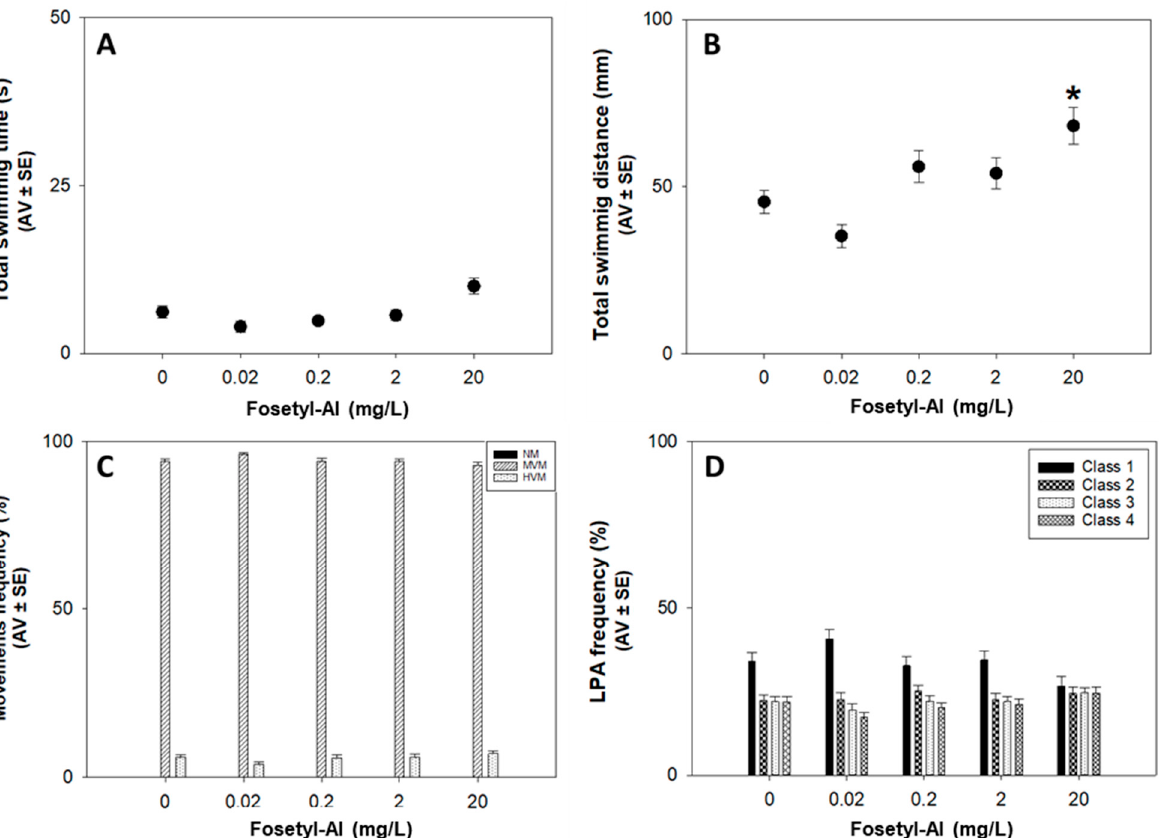
Figure 2. Effects of 120 h of exposure to fosetyl-Al on zebrafish larvae for total swimming time ( A ) and distance ( B ); types of movements ( C ); and larvae path angle (LPA) ( D ). NM, no movements; MVM, medium-velocity movements; HVM, high-velocity movements. Class 1: big amplitude angles (90–180 ◦ ); Class 2: medium amplitude angles (30–90 ◦ ); Class 3: medium amplitude angles (10–30 ◦ ); Class 4: small amplitude angles (0–10 ◦ ). Data are expressed as average value (AV) ± standard error (SE). * Significant differences to control ( p <